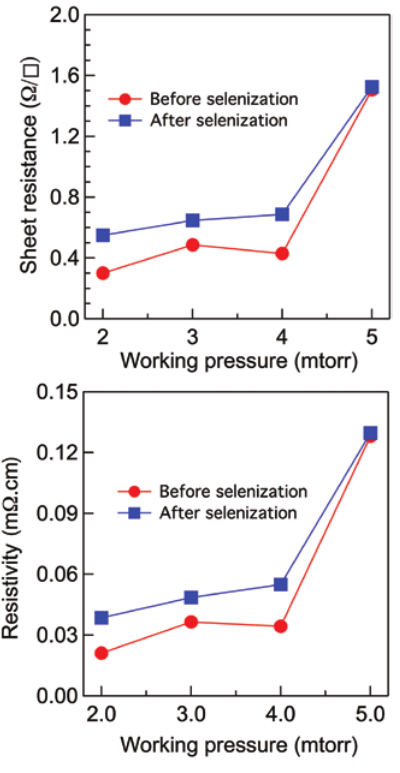
FIgure 6: Variation of sheet resistance and resistivity of Mo films before and after selenization with working pressures.